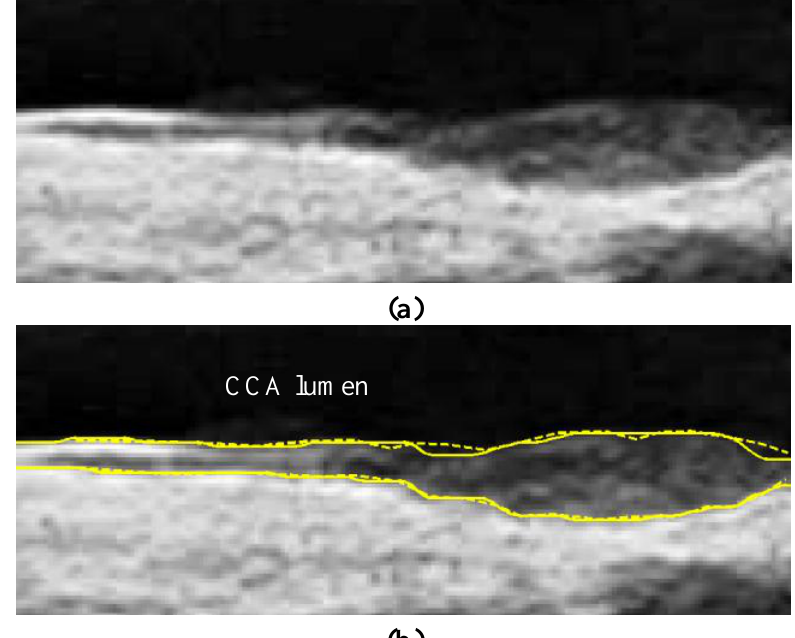
Figure 6. Far wall IMT detection. (a) Raw sub-image. (b) Solid line: Automatic detection result. Dash line: Manual drawing. (Sequence